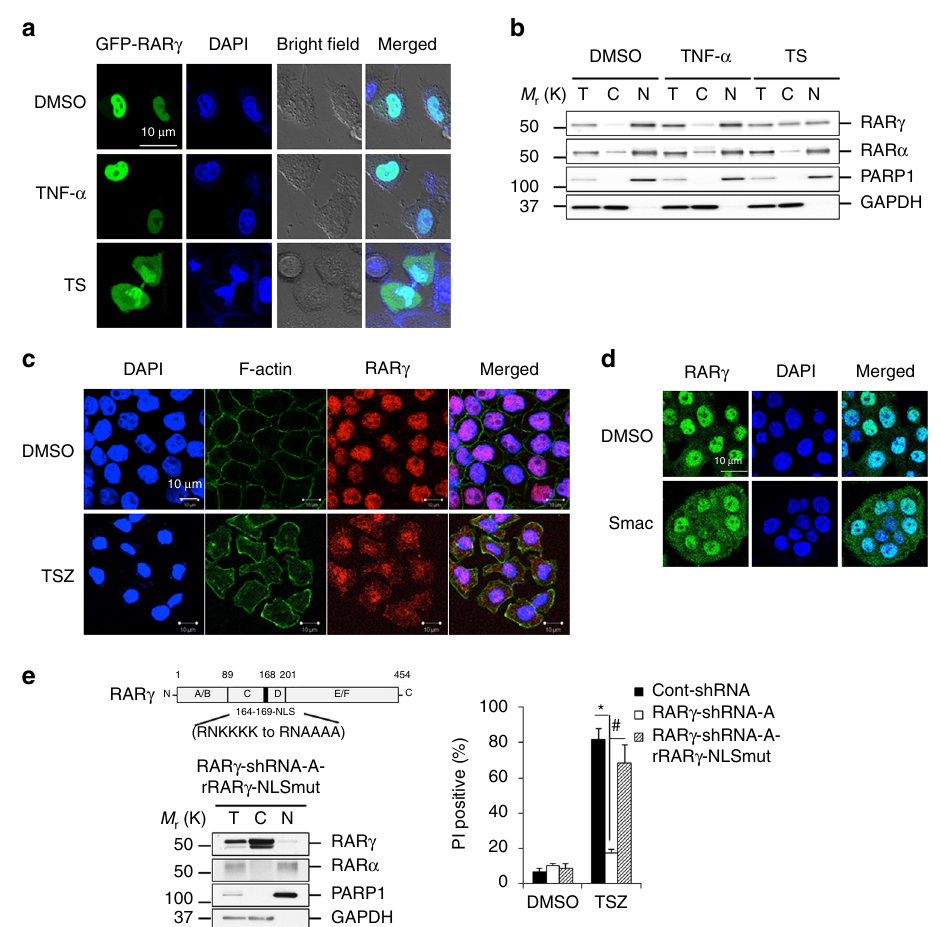
Fig. 2 Cytosolic RAR γ mediates apoptosis and necroptosis. a Confocal microscopy of HeLa cells transfected with RAR γ -GFP plasmid and treated with DMSO, TNF- α or TS for 2 h. ( blue DAPI; green : RAR γ ) ( scale bar : 10 μ m). b The total (T), cytosolic (C) and nuclear (N) fractions analysis of HeLa cells treated with DMSO, TNF- α or TS for 4 h. Fractions were analyzed by immunoblotting with the indicated antibodies. c Confocal microscopy of HT-29 cells treated with DMSO or TSZ for 2 h. Cells were stained with nuclear DAPI ( blue ), anti-F-actin ( green ) and anti-RAR γ ( red ) antibodies ( scale bar : 10 μ m). d Confocal microscopy of HT-29 cells treated with Smac-minic for 2 h. Cells were stained with nuclear DAPI ( blue ) and anti-RAR γ ( green ) antibodies ( scale bar : 10 μ m). e Scheme for the mutation of RAR γ in NLS ( upper left panel ). The total (T), cytosolic (C) and nuclear (N) fractions of HT-29 RAR γ -shRNA-A cells infected with resistant RAR γ -NLS mutation lentiviral plasmid (RAR γ -shRNA-A-RAR γ -NLSmut). The cell lysates were by immunoblotted with the indicated antibodies ( lower left panel ). HT-29 cont-shRNA, RAR γ -shRNA-A or RAR γ -shRNA-A-rRAR γ -NLSmut cells were treated with TSZ for 24 h and PI-positive population was determined by fl ow cytometry ( right panel ). (* P < 0.05 versus cont-shRNA; # P < 0.05 versus RAR γ - shRNA-A; ANOVA). The bars represent the mean ± s.e.m. of three experiments. All images and blots above are representative of one of three